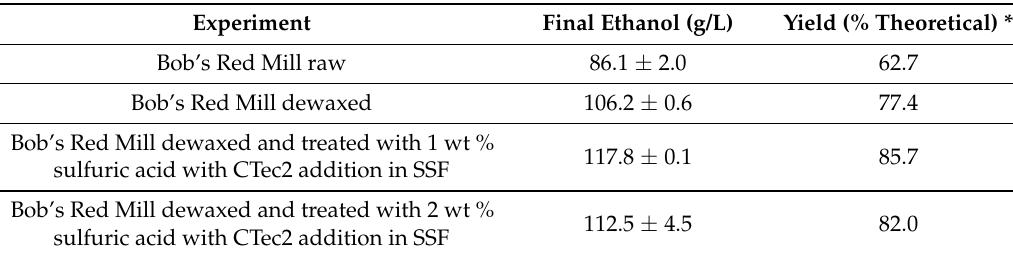
Table 6. Final ethanol concentrations obtained in SSF of raw, dewaxed, and dewaxed plus dilute H 2 SO 4 -treated and cellulase-treated BRM sorghums.